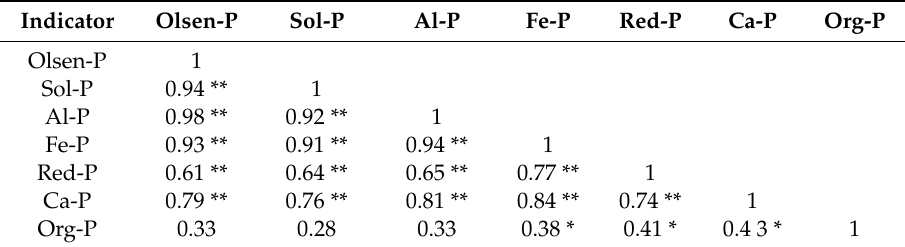
Table 4. Pearson correlation coefficients for soil Olsen-P and phosphorus fractions.